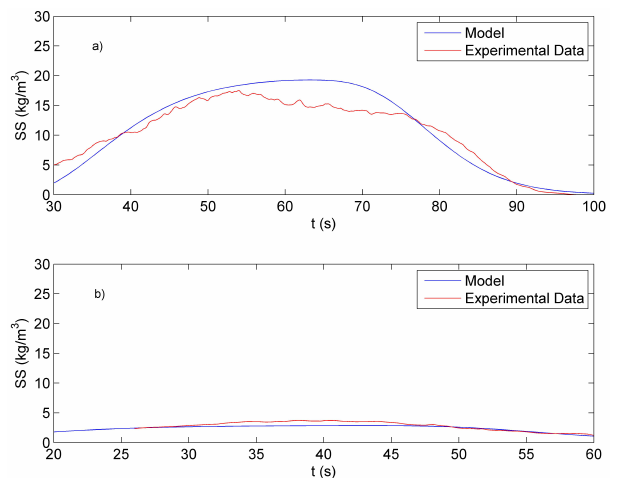
Fig. 2. (a) Comparison of model results with the recorded data in the trial without current. (b) Comparison of model results with the recorded data in the experiment with the presence of 0.1ms − 1 cur-